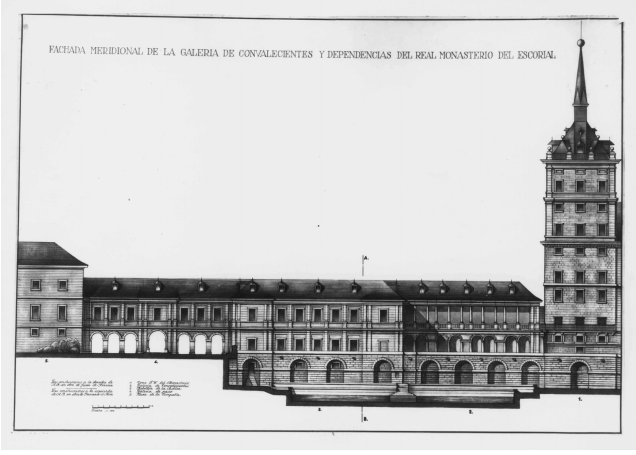
Figure 4. Manuel Lorente, 1944: Fachada principal de la Galería de Convalecientes y dependencias del Real Monasterio del Escorial . Colegio Oficial de Arquitectos de Madrid (Spain), Servicio Histórico, Legado Lorente Junquera, Bookmark MLJ/P01/B3-1-02.